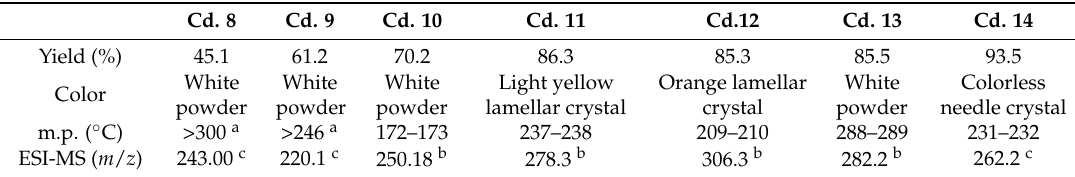
Table 3. The yields, colours, and ESI-MS data of Cds. 8 – 14 .